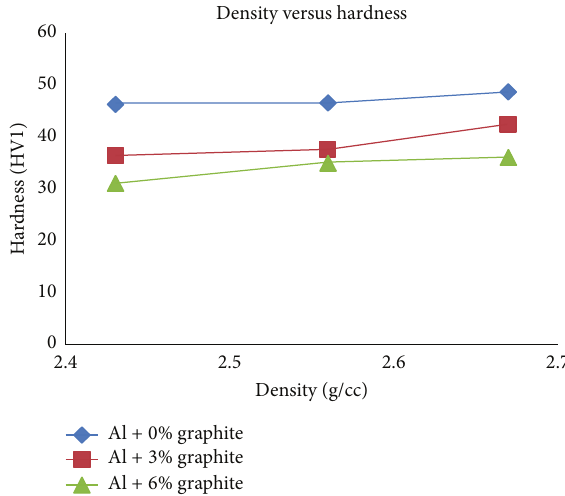
Figure 3: Variation of hardness of Al-Gr composites with varying